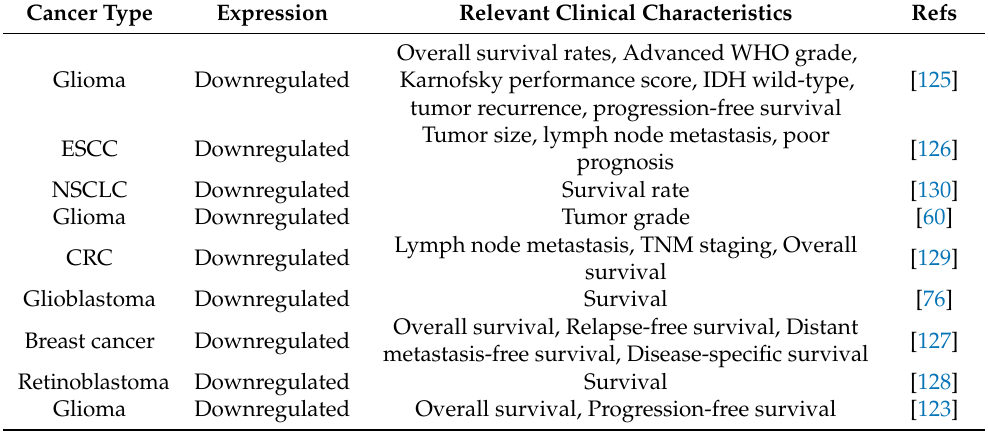
Table 2. MEG3 expression and relevant clinical characteristics in human